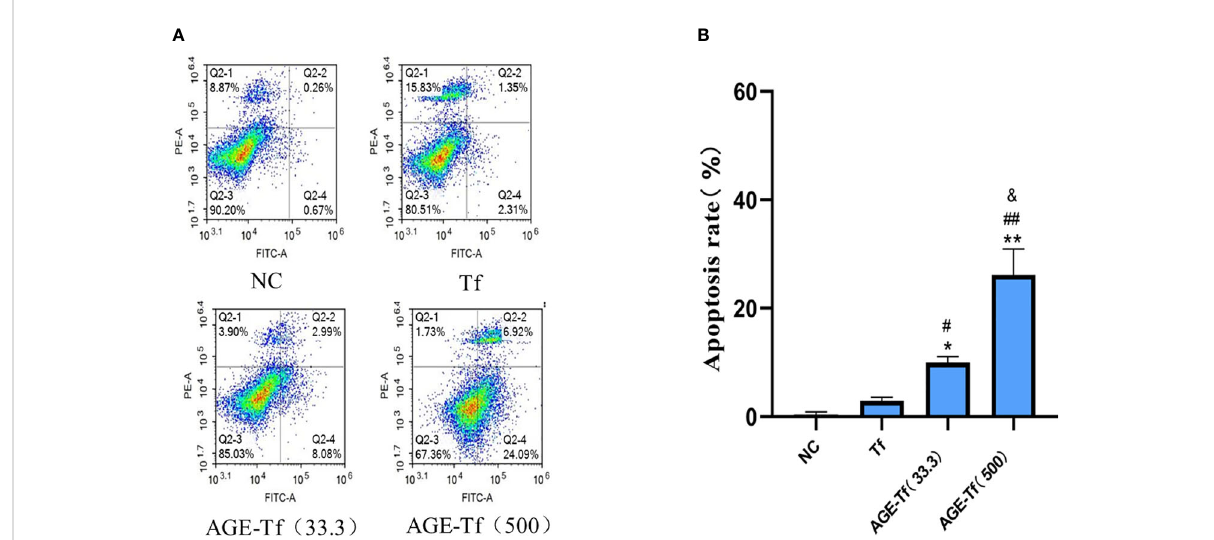
FIGURE 4 Effect of AGE-Tf on apoptosis of HK-2 cells. (A) HK-2 cell apoptosis diagram under different intervention conditions. (B) Statistical analysis of apoptosis rate. Compared with the NC group, *p < 0.01, **p < 0.001. Compared with the Tf group, # p < 0.05, ## p < 0.01. Compared with the AGE-Tf (33.3) group, & p < 0.05. AGE-Tf (33.3): the glucose concentration was 33.3 mM when preparing AGE-Tf; AGE-Tf (500): the glucose concentration was 500 mM when preparing AGE-Tf.